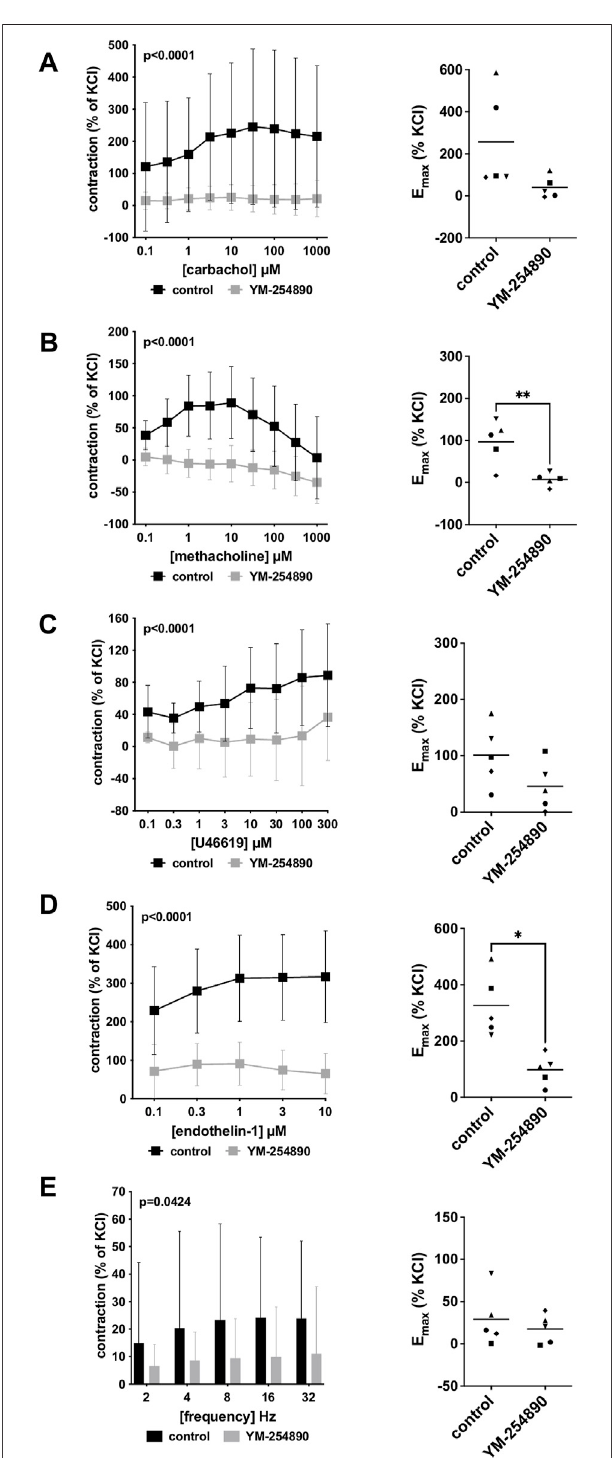
FIGURE 4 | Effects of YM-254890 on cholinergic and non-cholinergic, and EFS-induced neurogenic contractions of porcine coronary artery tissues. Cholinergic contractions were induced by the m-cholinreceptor agonists carbachol (A) , and methacholine (B) , while non-cholinergic contractions were induced by thromboxane A2 analog U46619 (C) and endothelin-1 (D) ,